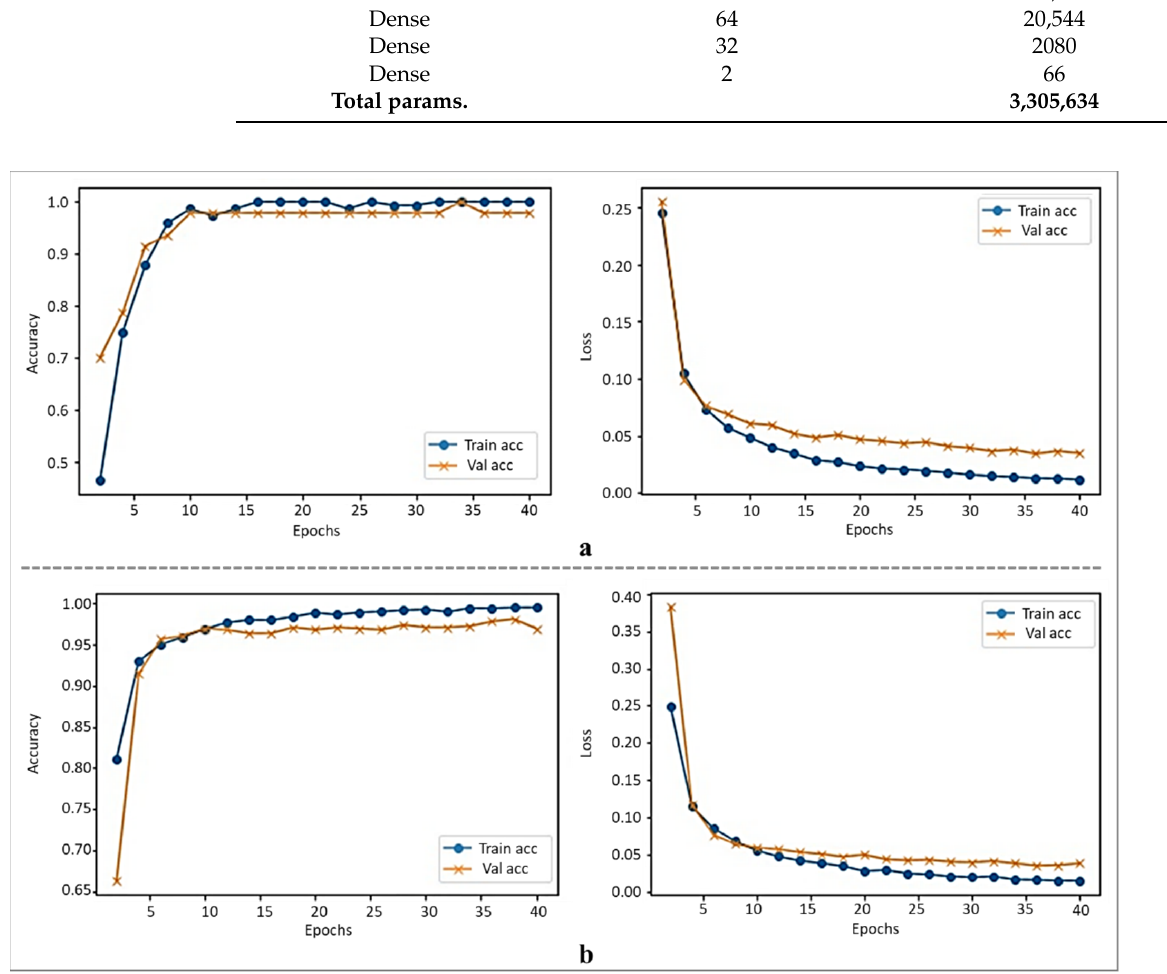
Figure 2. The training loss and accuracy of the proposed model, ( a ) the loss and accuracy over the FMD dataset; ( b ) the loss and accuracy over the FM dataset.